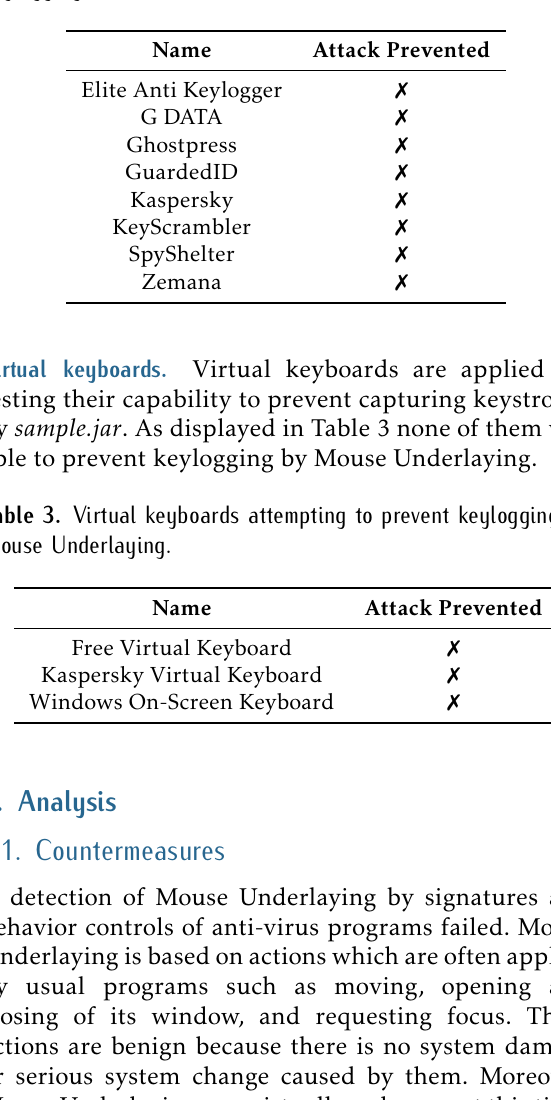
Table 2. Keylogger protection software attempting to prevent keylogging.